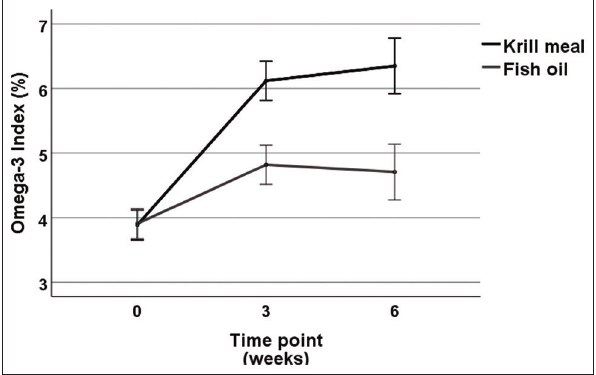
Figure-1: Mean (±95% confidence interval) omega-3 index values (%) across the study period by supplement